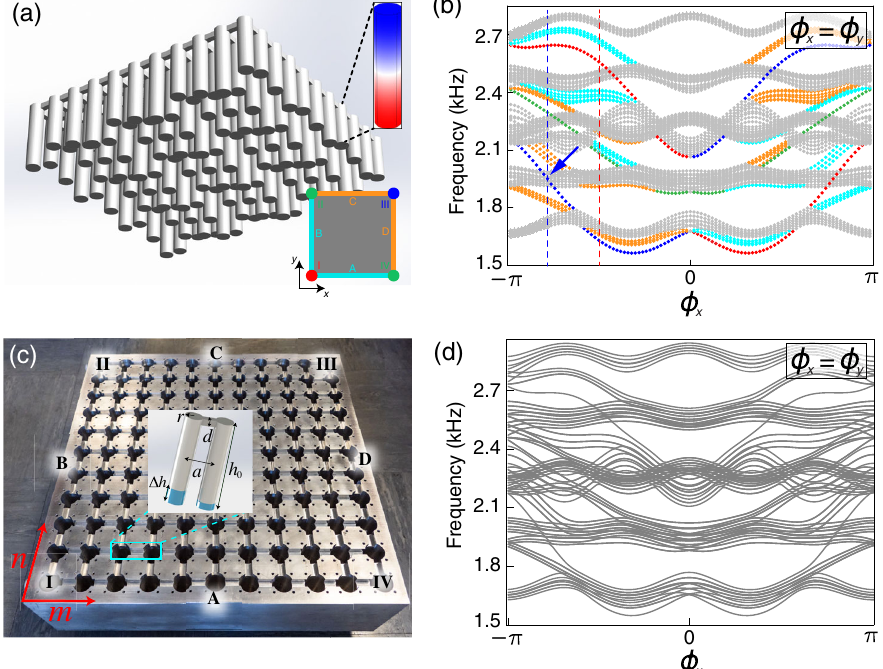
FIG. 3. Realizing the 4D system using a 2D acoustic lattice. (a) A schematic drawing of an acoustic system consisting of cavities with modulated heights. The inset shows the fundamental cavity mode which is used as the on-site orbital, where red (blue) represents positive (negative) sound pressure. In (b), the eigenspectra along ϕ x ¼ ϕ y are plotted as functions of ϕ x . The results are from finite- element simulations. The five gray regions are bulk bands, and the cyan and orange dots are in-gap THMs. The red, green, and blue dots indicate TSMs. The colors of modes indicate their characteristics, which are represented in the inset in (a). The blue arrow in (b) indicates a TSM that overlaps with bulk bands, making it a bound state in the continuum. The red dashed line marks ϕ x ¼ − 0 . 5 π , and the blue dashed line marks ϕ x ¼ − 0 . 78 π . (c) A photograph of our acoustic lattice with 11 × 11 coupled cavities. To implement the two synthetic dimensions ð ϕ x ; ϕ y Þ , the height of each cavity is tuned by injecting a specific amount of water, as illustrated in the inset. (d) The eigenspectra along ϕ x ¼ ϕ y based on the modified tight-binding model. Excellent agreements with the results from simulations are